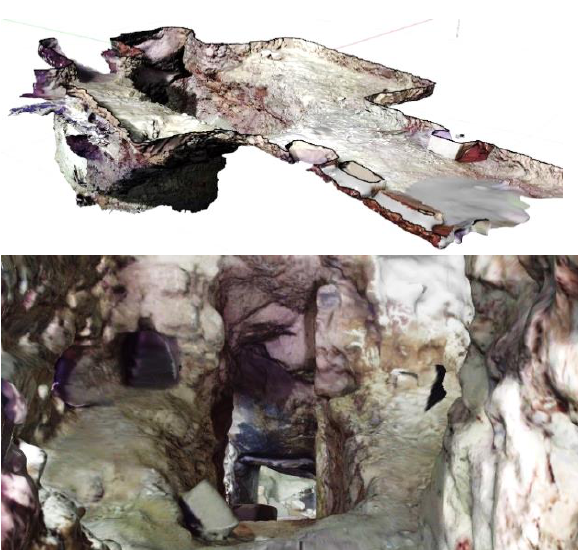
Figure 10 and 11: Access to the Ipi’s sarcophagus. Final model of the 3d scan,